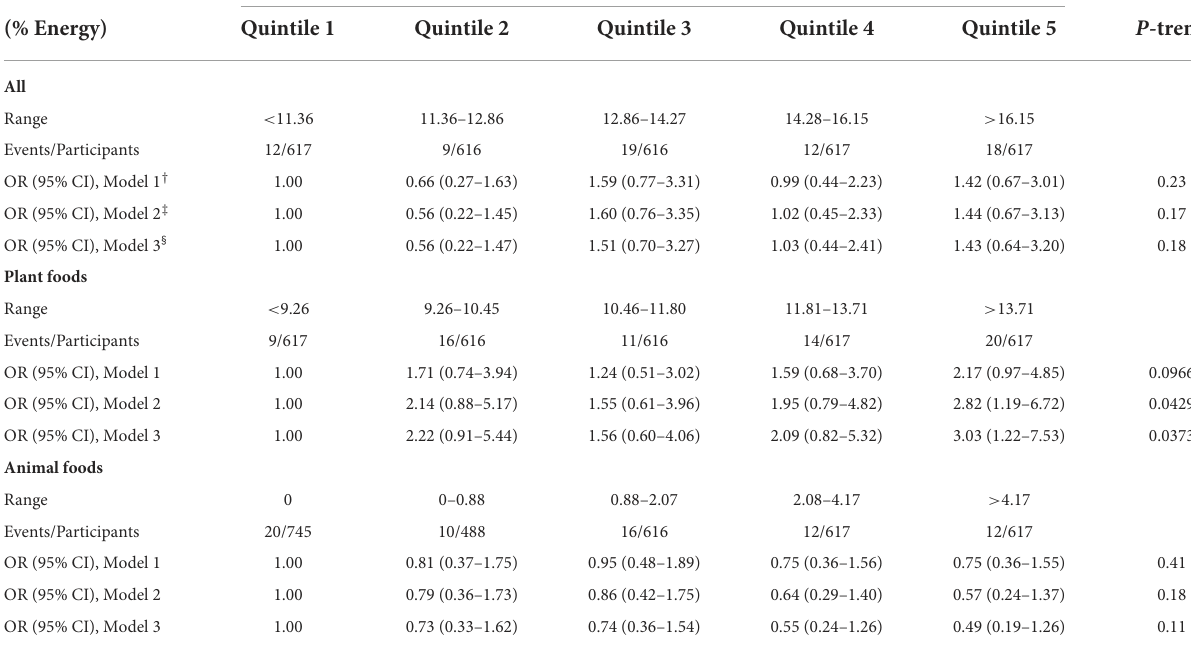
TABLE 4 Protein intake from different sources and cognitive decline *